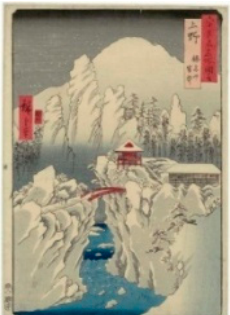
Figure 8. Utagawa Hiroshige (1797–1858), Mount Haruna under the Snow , https://en.wikipedia.org/